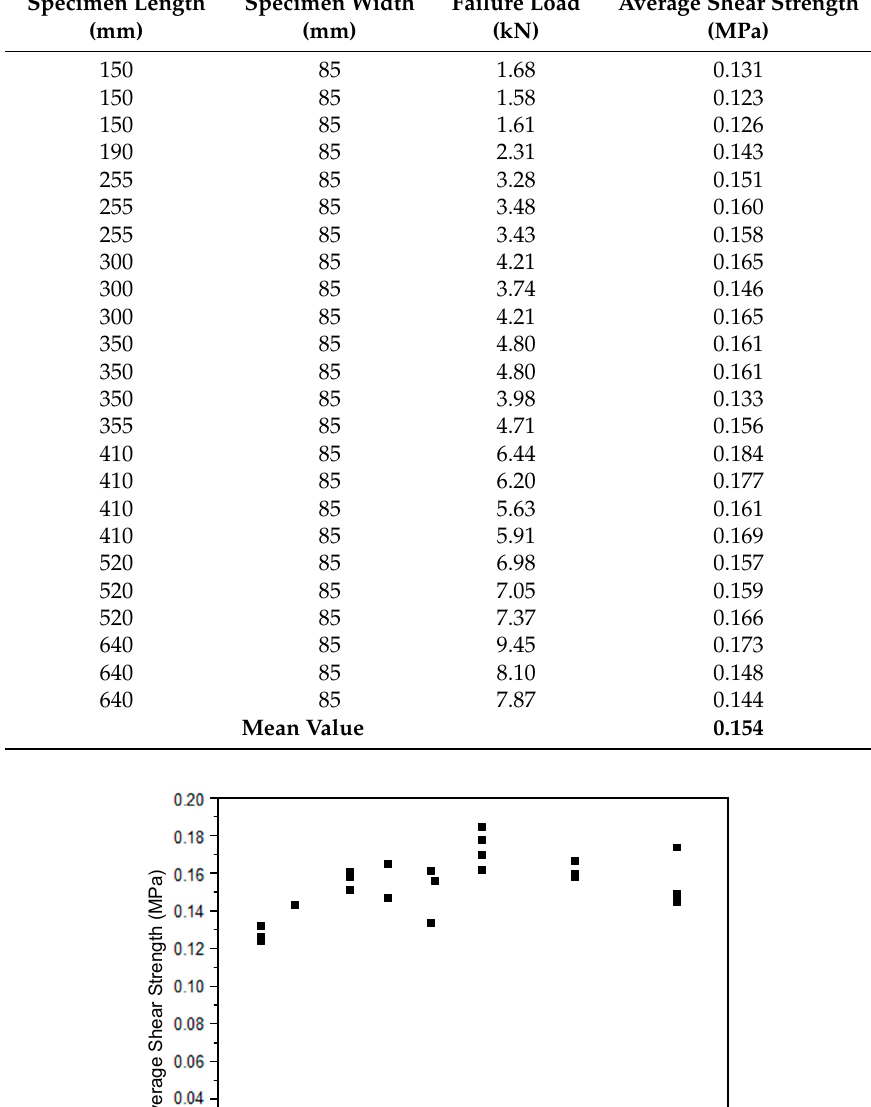
Table 2. Average shear strength of bond specimens.